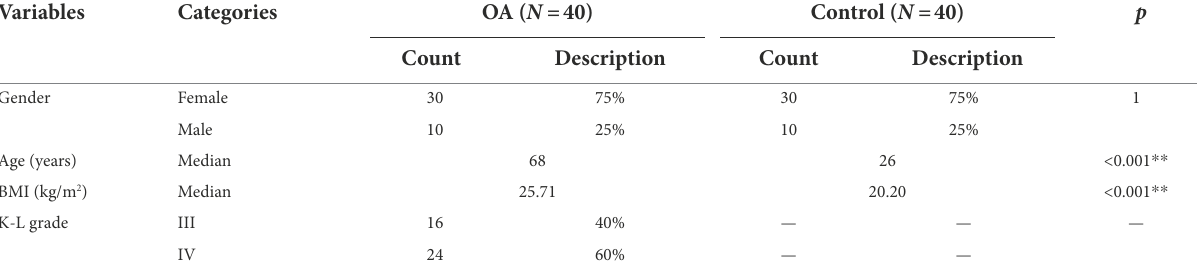
TABLE 1 Basic characteristics of the OA and control group.